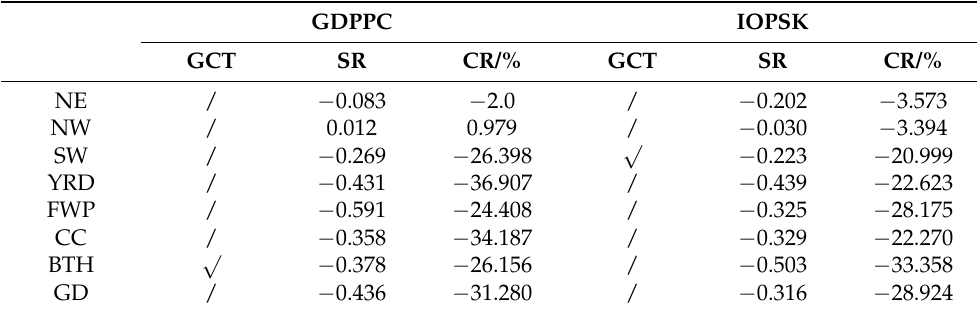
Table 3. Driving force analysis performed on a regional scale between AOD and socioeconomic factors of major regions. GDPPC IOPSK GCT SR CR/% GCT SR CR/% NE / − 0.083 − 2.0 / − 0.202 − 3.573 NW / 0.012 0.979 / − 0.030 − 3.394 √ − 26.398 − 0.223 − 20.999 YRD / − 0.431 − 36.907 / − 0.439 − 22.623 / − 0.591 − 24.408 / − 0.325 − 28.175 CC / − 0.358 − 34.187 / − 0.329 − 22.270 − 0.378 − 26.156 − 0.503 − 33.358 − 31.280 − 0.316 −